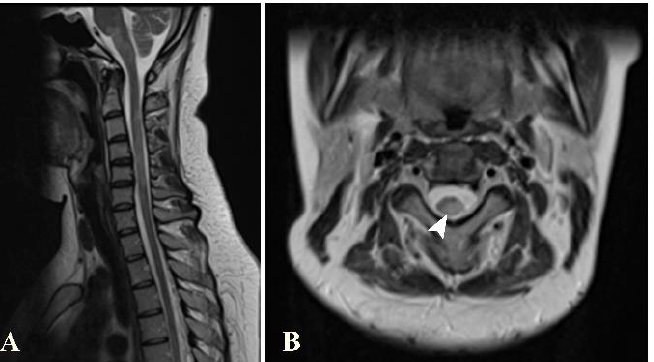
Figure 7. Sagittal T2W image ( A ) of the cervical spine shows brainstem and several spinal cord lesions. Axial T2W image ( B ) shows lesions involving both central and peripheral regions of the spinal cord (arrowhead), mainly in lateral and posterior columns. Table 3. Spinal MRI findings (Spinal MRI was applicable in 26 patients).